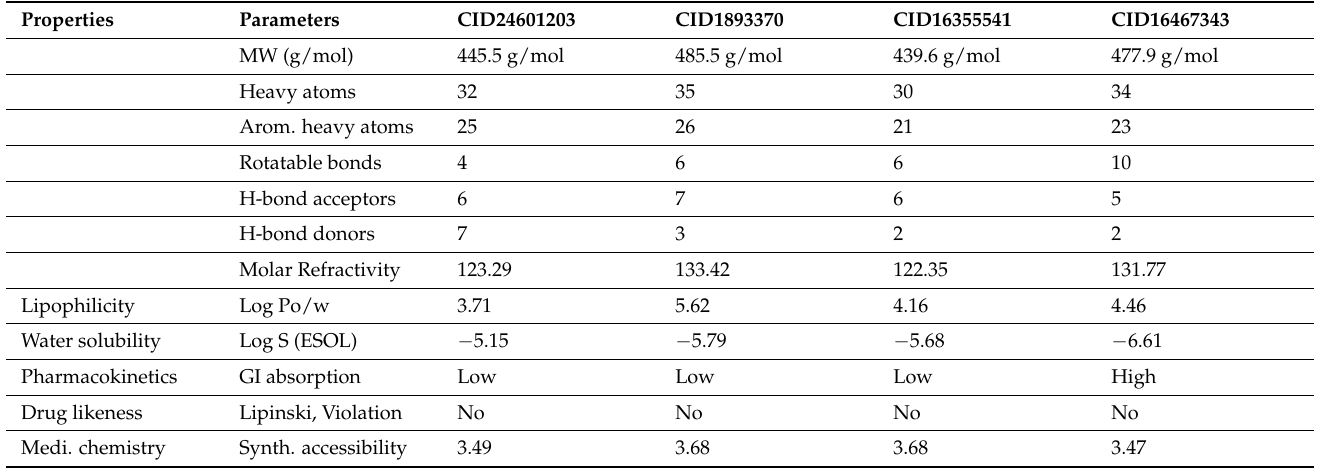
Table 4. List of pharmacokinetic properties (physico-chemical, lipophilicity, water solubility, drug likeness, and medicinal chemistry) of the selected four compounds.